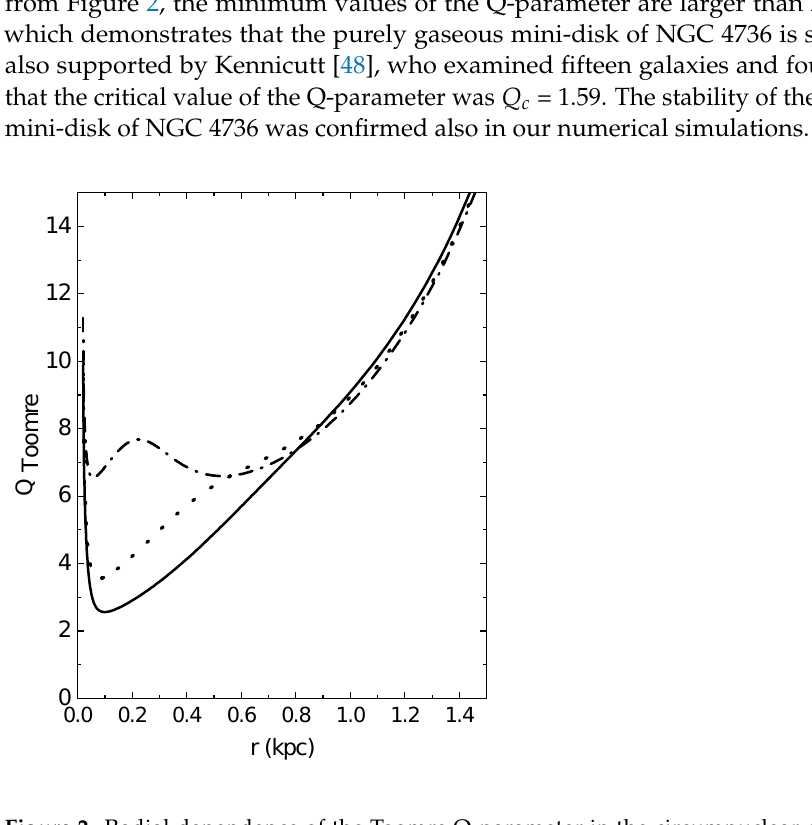
Figure 2. Radial dependence of the Toomre Q-parameter in the circumnuclear disk of NGC 4736 for three different initial rotation curves with r 0 as 0.3 kpc (dash-dotted line), 0.6 kpc (dash line), and 0.9 kpc (solid